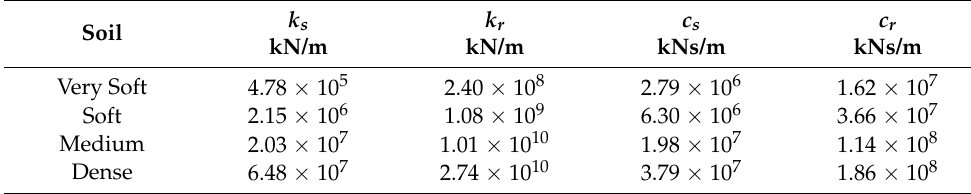
Table 3. Soil properties of the forty-story buildings.